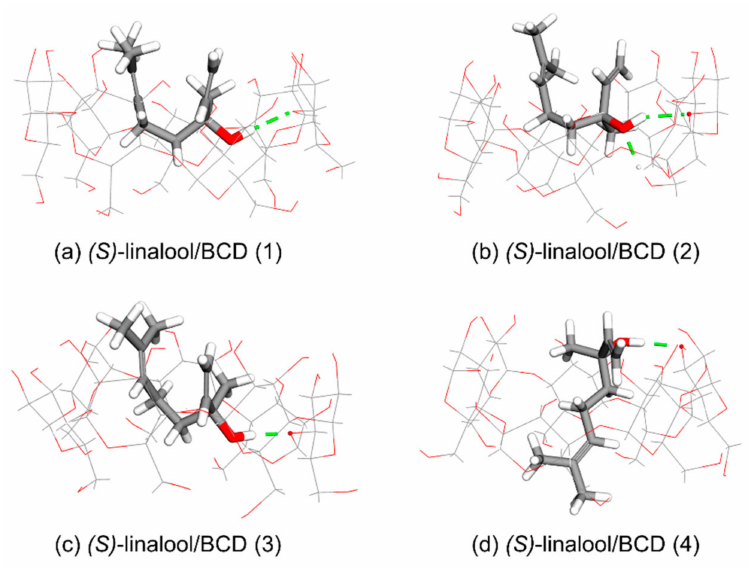
Figure 4. Energy-minimized structure of the 1:1 ( S )-linalool/BCD complexes from four clusters using PM7 method. BCD is presented as a line model. The linalool molecule is presented as a stick model. The green dashed line refers to hydrogen